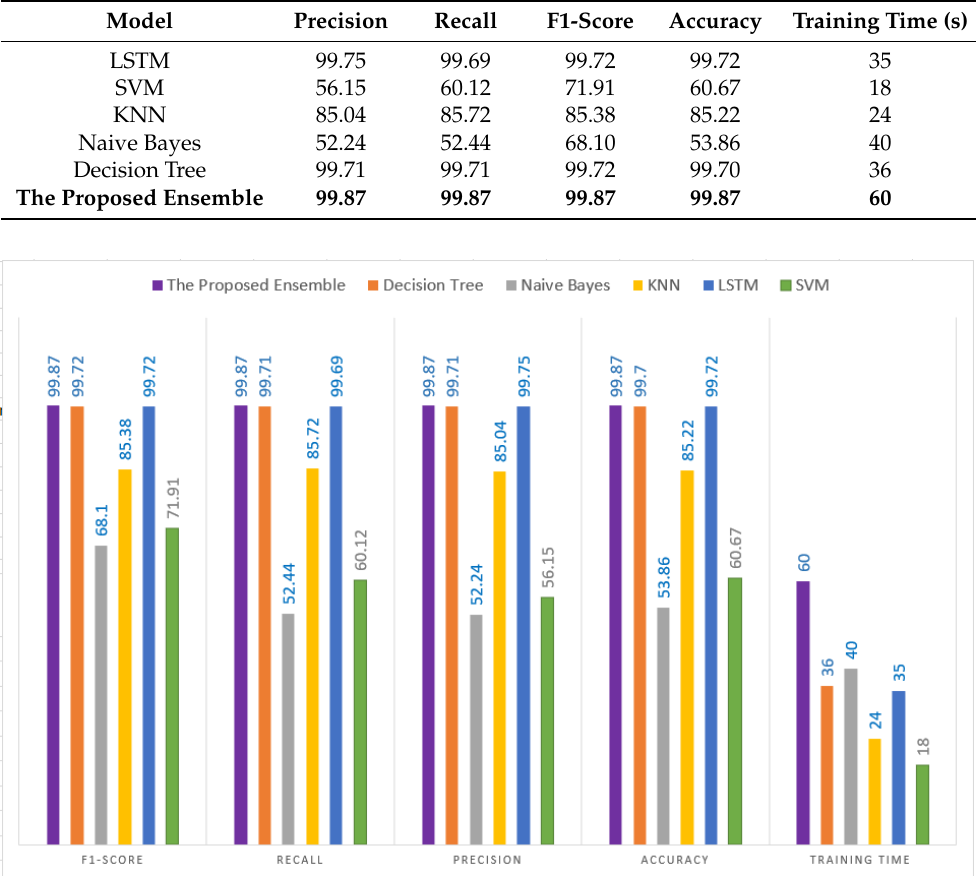
Figure 8. The performance evaluation of each model